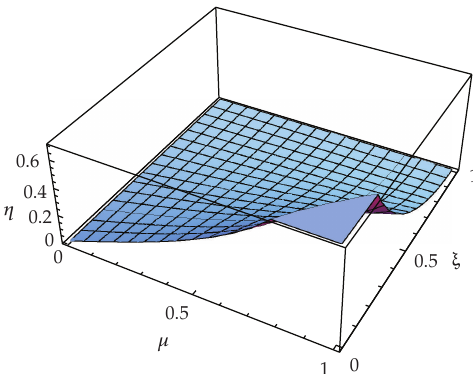
Figure 4: The sheared cantilever: a 3D dimensionless plot of deflection η versus position ξ and load intensity μ .